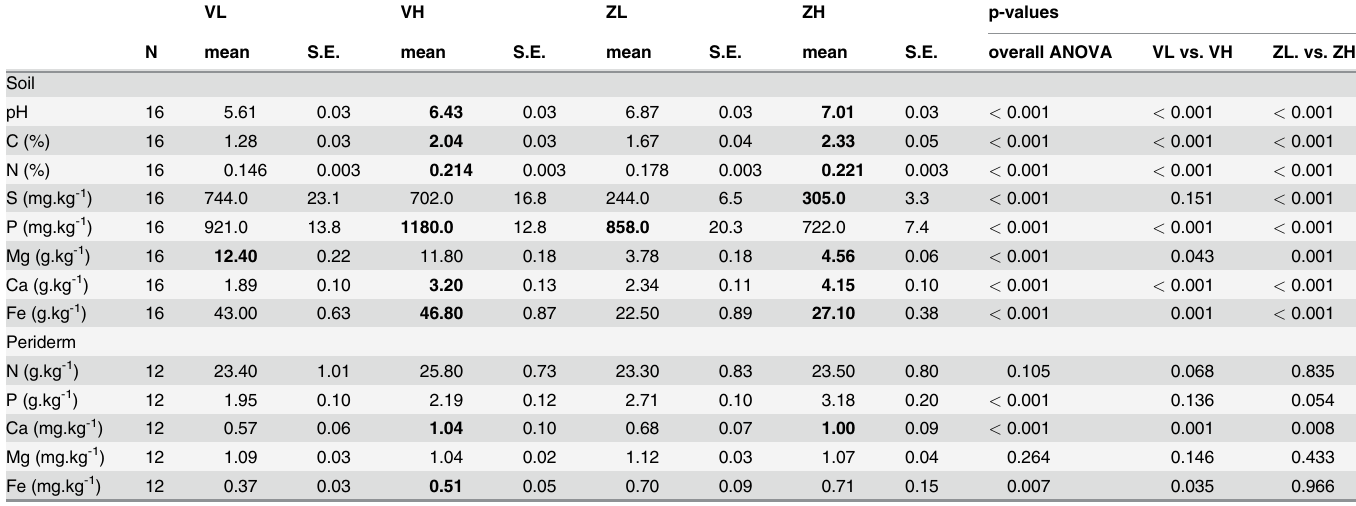
Table 3. Chemical characteristics in soil and periderm. VL VH ZL